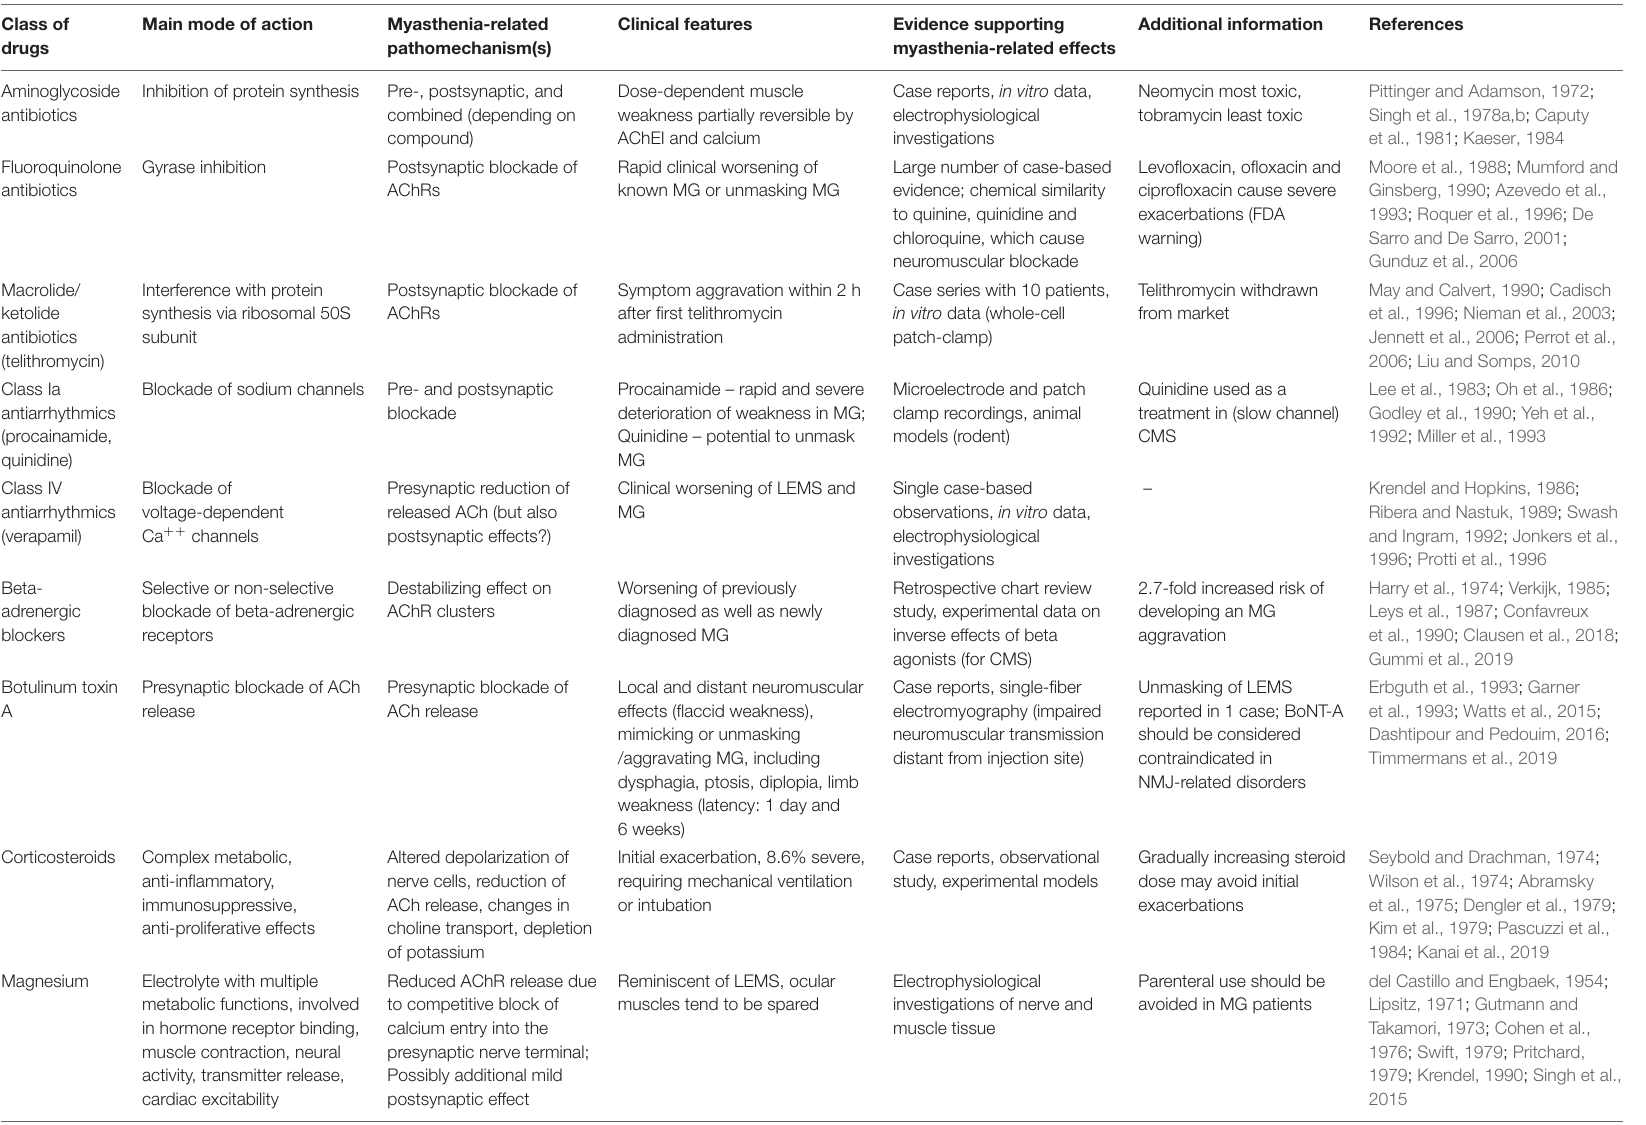
TABLE 1 | Selection of clinically relevant classes of drugs associated with exacerbations of pre-existing myasthenic syndromes. Class of